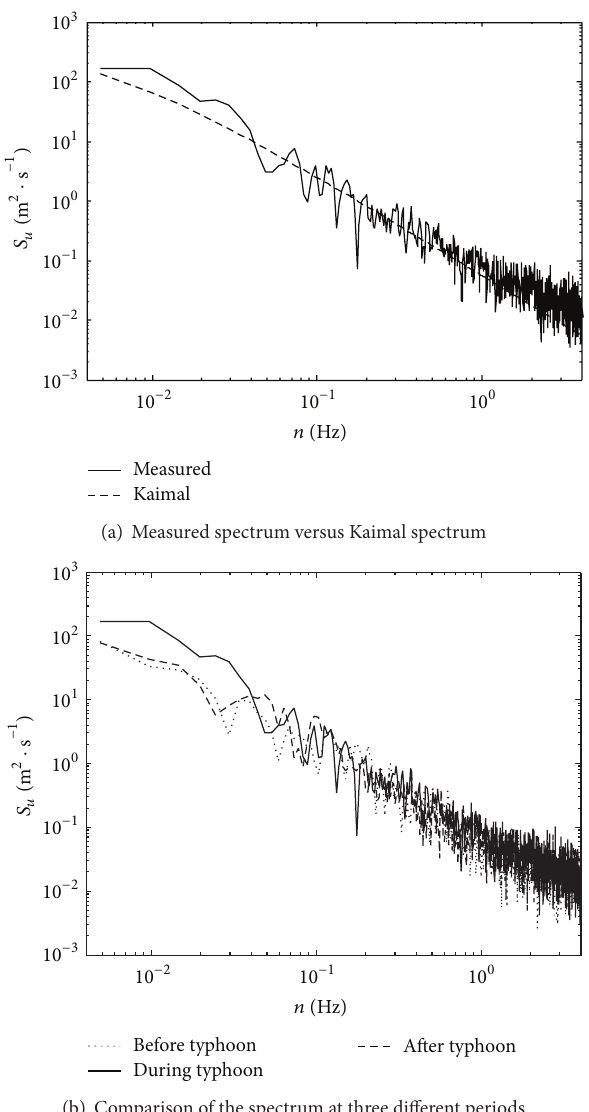
(b) Comparison of the spectrum at three different periods Figure 12: Analysis of along-wind turbulence power spectrum of Typhoon